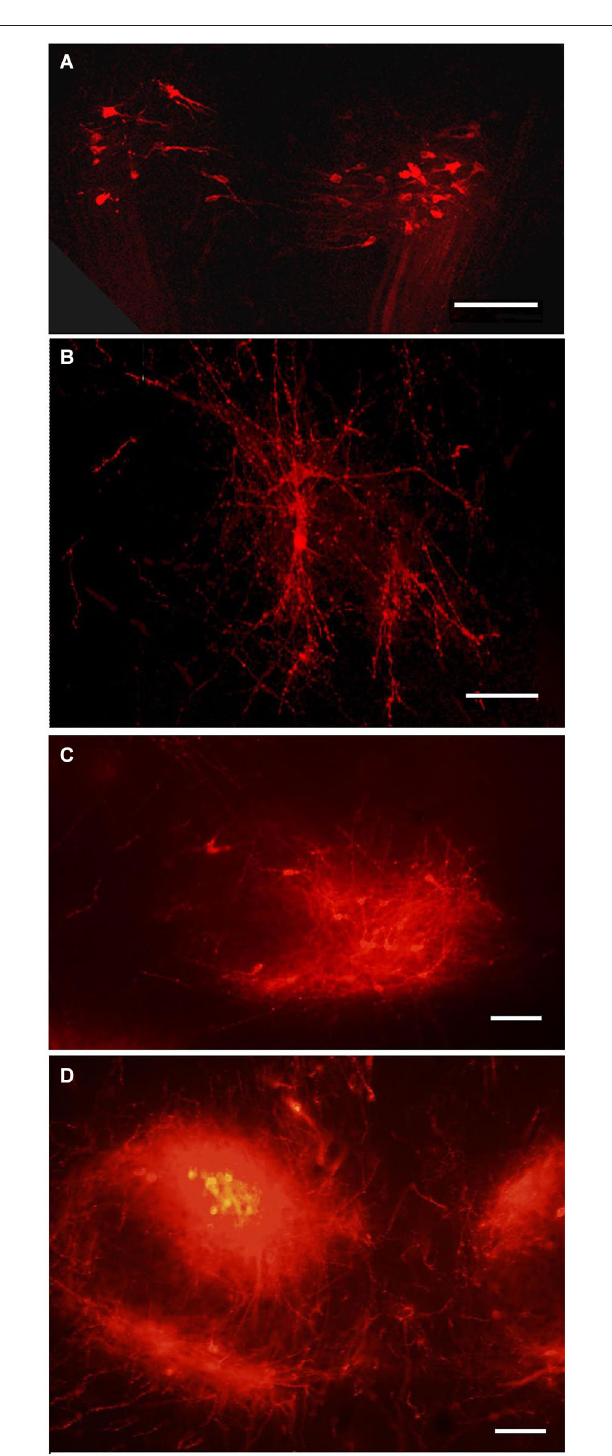
FIGURE 5 | Tegmental neurons innervating MBO . DiI labeled neurons in the tegmentum following DiI insertion into the MBO on different prenatal stages: (A) E14, bilateral groups of neurons on a coronal section; (B) E19, confocal image of the same neurons, in sagittal section; (C) P1, the ventral tegmental nucleus on sagittal section; (D) P10, ventral tegmental nuclei on coronal section. Scale bars: (A,B) = 80 µ m, (C,D) = 100 µ